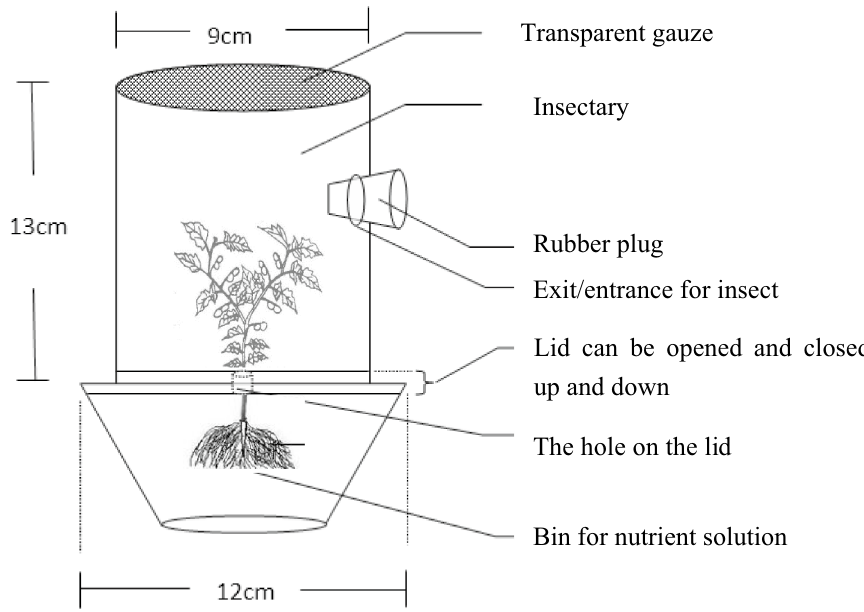
Figure 3. Microcosm for host suitability experiment of Necremnus tutae on Tuta